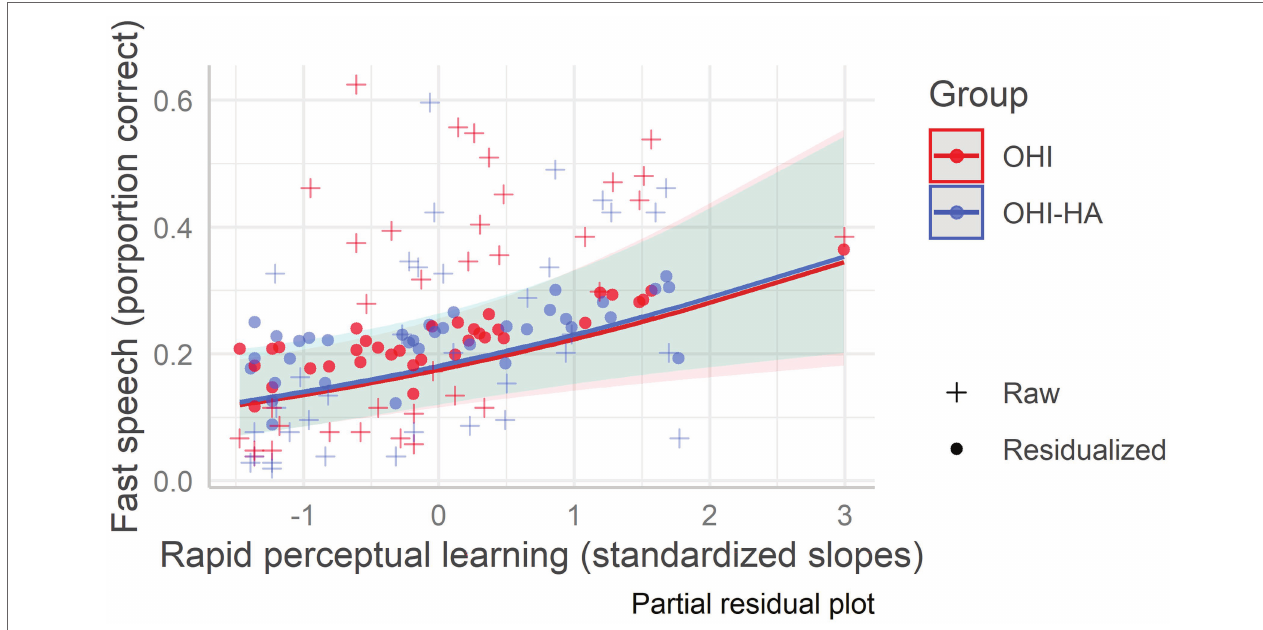
FIGURE 3 | Fast speech recognition as a function of rapid learning among older hearing-impaired adults and older hearing-impaired adults who use hearing aids. Older hearing-impaired adults (OHI) in red; older hearing-impaired adults who use hearing aids (OHI-HA) in blue. The y -axis indicates the correct perception percentage of fast speech, and the x -axis indicates the standardized rapid perceptual learning slope. The dots (residualized aggregate scores) mark the predicted scores; their deviation from the regression line indicates prediction error, while the pluses mark the raw/true scores. The shaded areas are the confidence intervals.